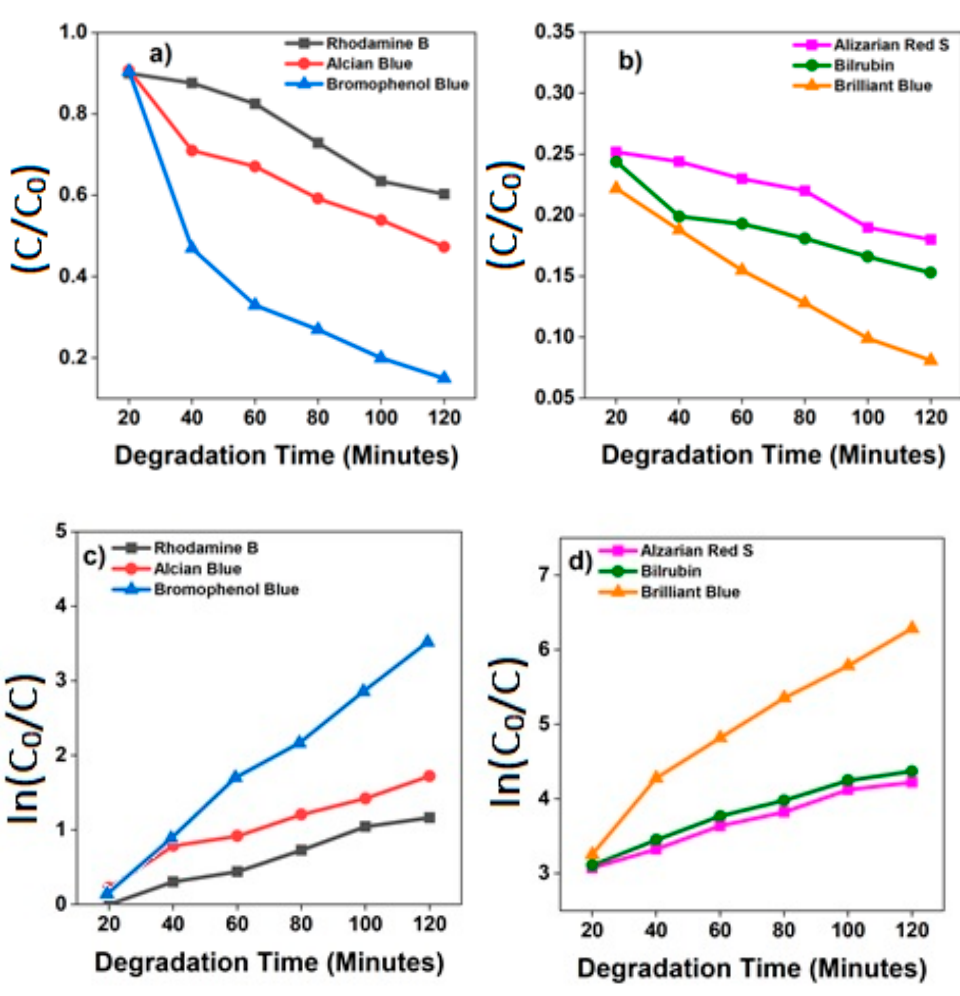
Figure 6. ( a , b ) The rate of the reaction for Alcian Blue, Alizarin Red S, Bilirubin, Brilliant Blue, Bromophenol Blue, and Rhodamine B; ( c , d ) rate constant evaluation from the linear fitting using equation k = − 2.303 × log(C 0 /C).